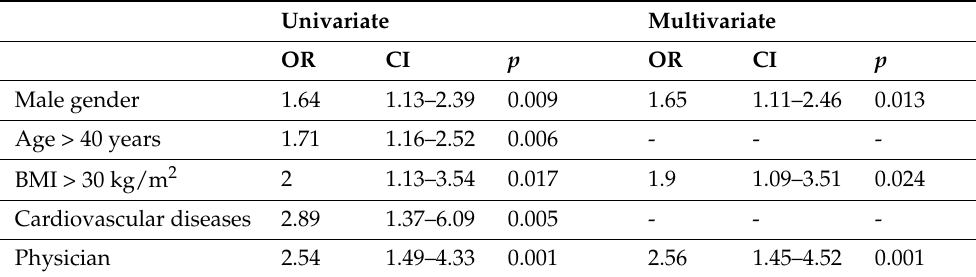
Table 2. Predictors of severity among healthcare workers with COVID-19 (backward